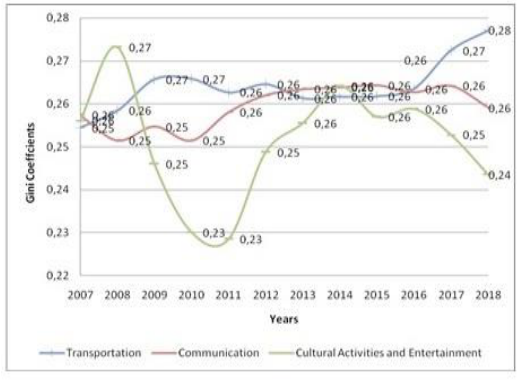
Figure 4. The Course of Gini Coefficients of Inequalities of Expenditure Rates at NUTS-2 Level